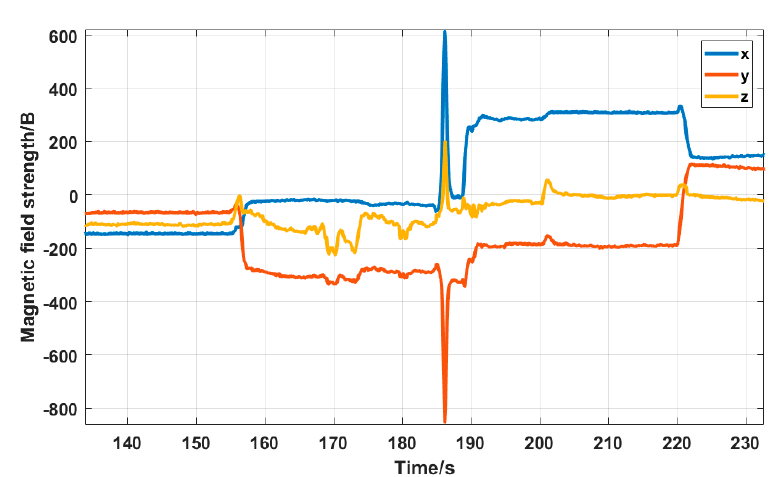
Figure 15. Triaxial magnetic field strength.